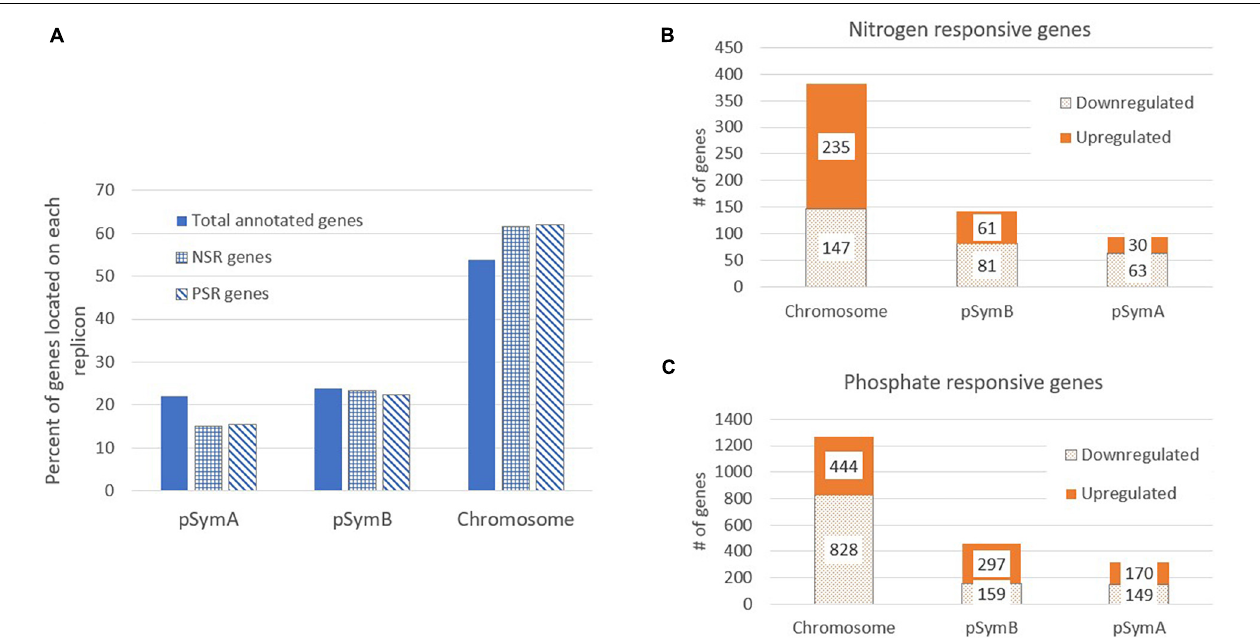
FIGURE 2 | Distribution of Nitrogen and Phosphate responsive genes on the S. meliloti replicons. (A) The percent of S. meliloti genes located on each replicon is shown for total annotated genes (solid bars), the nitrogen responsive genes (NSR) (checkered bars) and the phosphate responsive genes (PSR) (striped bars). The number of genes with significant expression changes in response to nitrogen stress (B) or phosphate stress (C) are indicated for each replicon. Each bar is split and shows the number of upregulated (solid bars) and downregulated (dotted bars) genes per replicon.